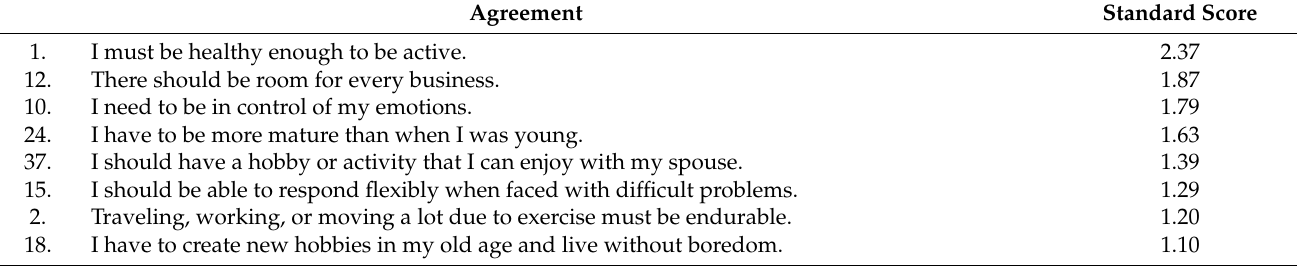
Table 6. The Q-statements with strong agreement or disagreement by Type